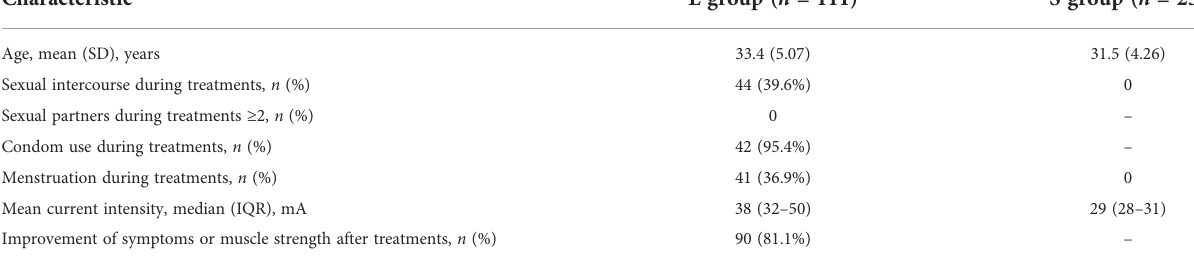
TABLE 1 Characteristics of all participants ( n =